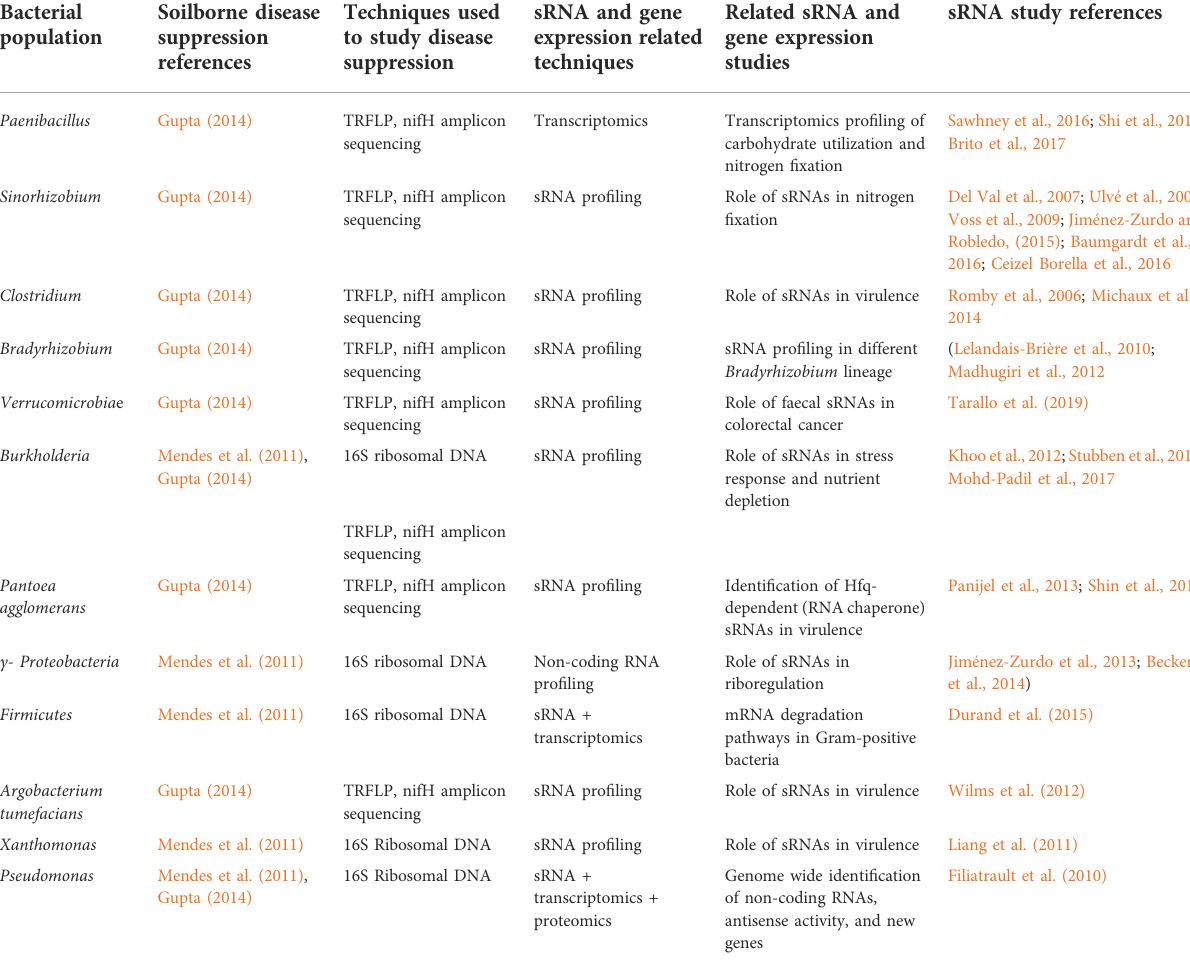
TABLE 1 Bacteria identi fi ed in soil-borne disease suppression communities that have also been the subject of sRNA studies. Bacterial